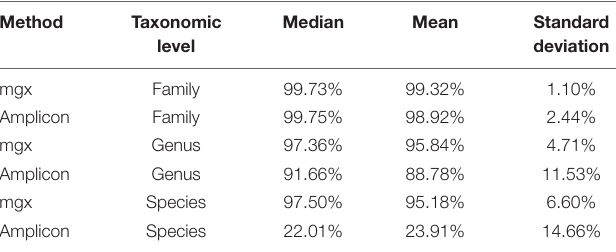
TABLE 1 | 16S rRNA profiling resolves more taxa down to the family level, but fewer to the species